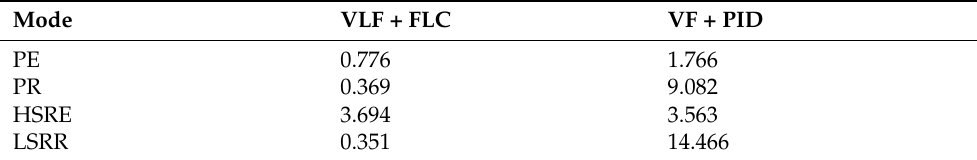
Table 5. Root means square error for metering modes on both control